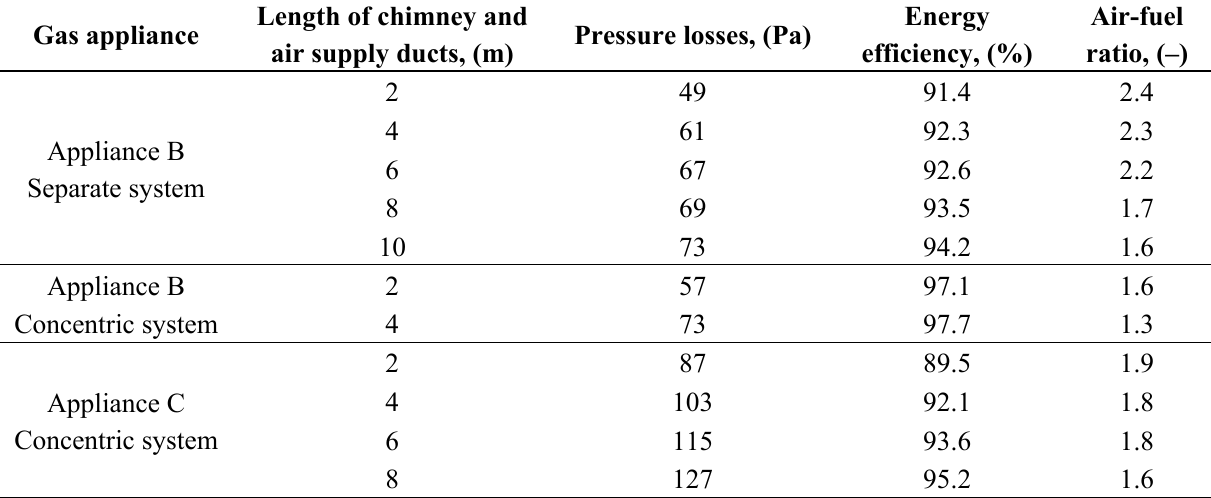
Table 4. Examination results for single family